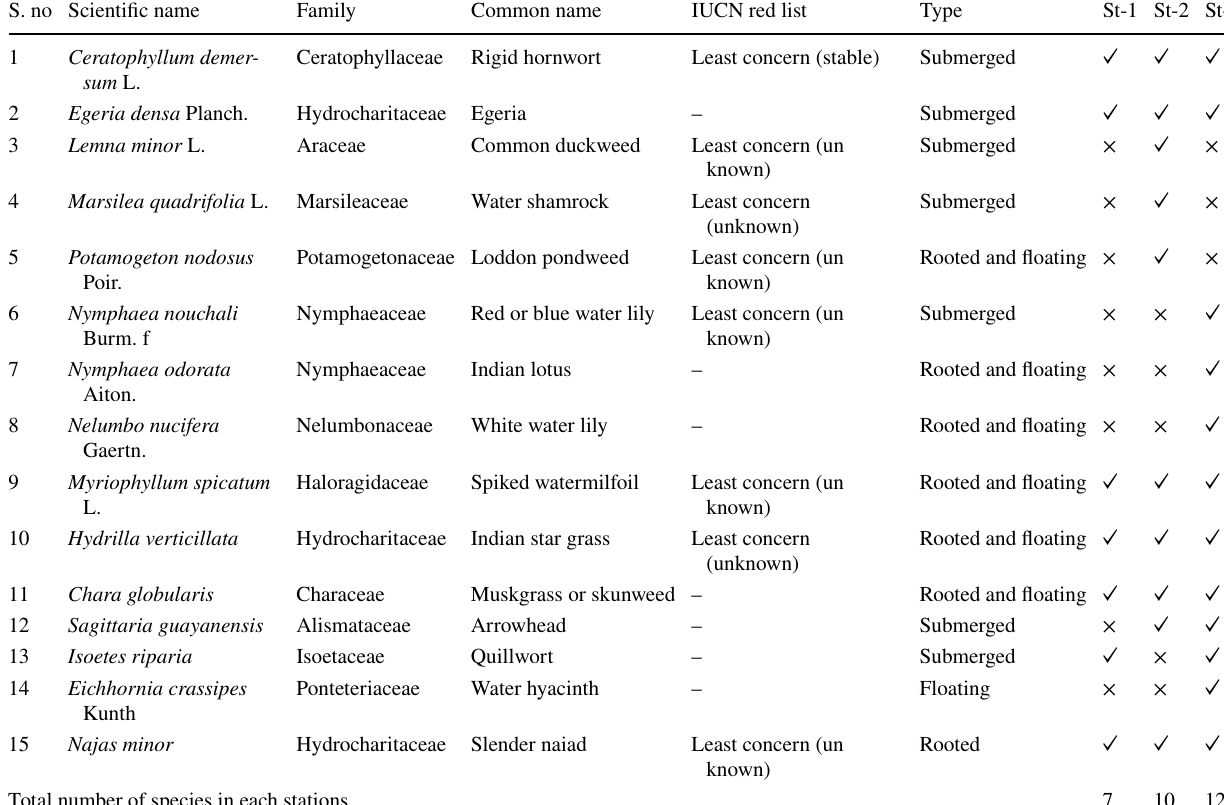
Table 3 List of aquatic plants species that were recorded in the seasonal